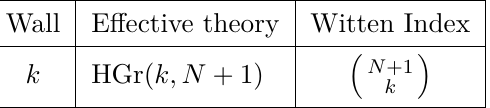
Table 3 . IR models on the vacuum structure of (4.1) for m < 0 . The various contributions to the Witten index are